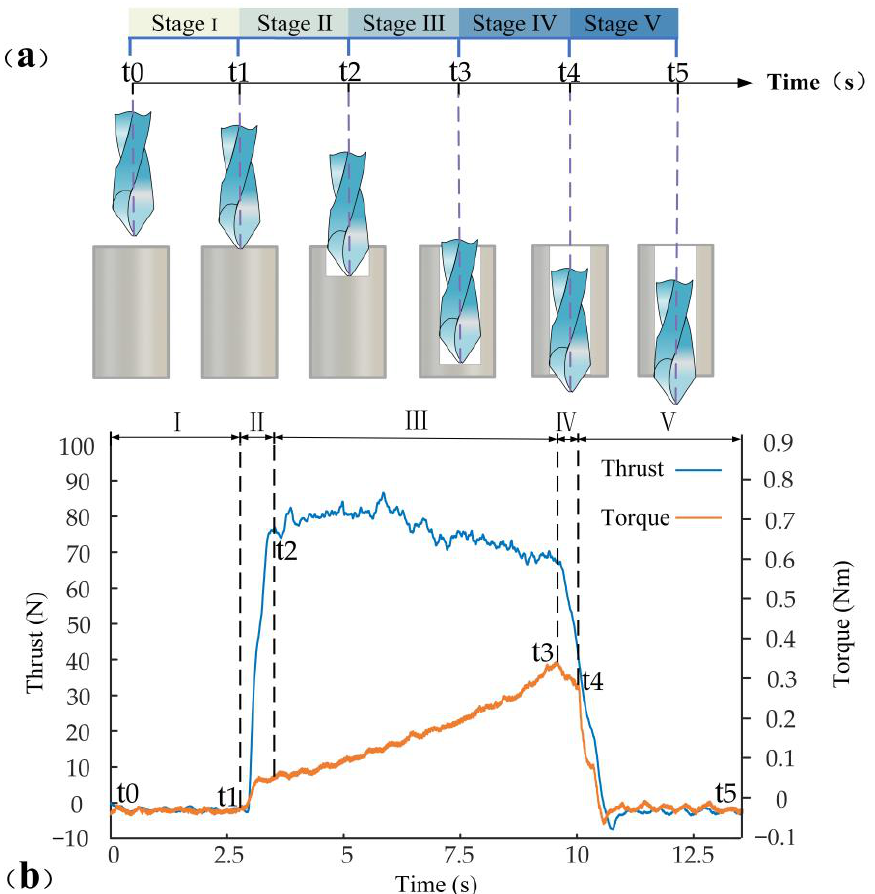
Figure 4. Drilling process diagram: ( a ) Schematic diagram of drilling processing stage; ( b ) Curve of thrust and torque variation.